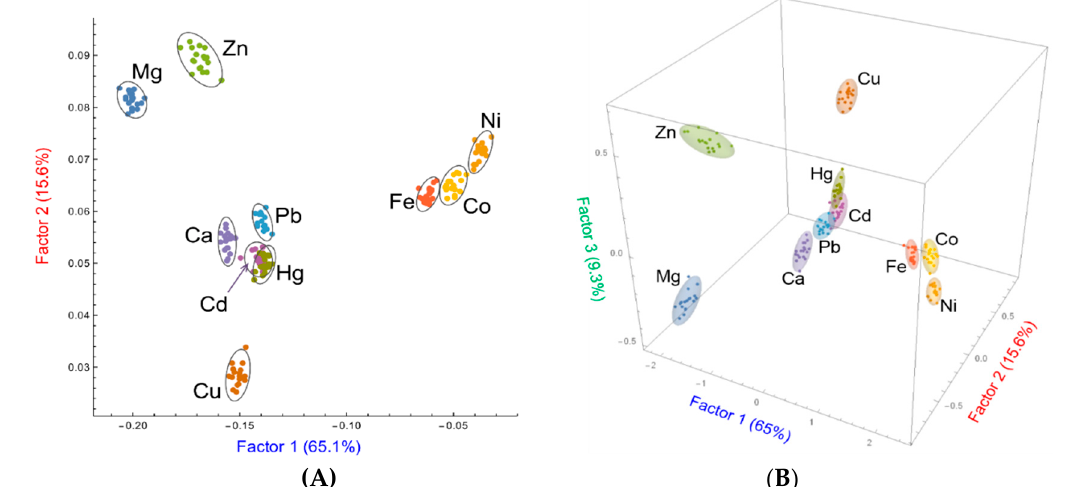
Figure 18. ( A ) Two-dimensional LDA score plot for the analysis of probes 45a – e binding 10 divalent metal chlorides. ( B ) A three-dimensional LDA score plot captured 90% of all information available from the pattern recognition system, significantly improving on the separation of difficult cases that were imperfectly discriminated, using the two-dimensional results. Confidence ellipsoids were drawn at 95% confidence. Adapted from [218] with permission from The Royal Society of Chemistry.